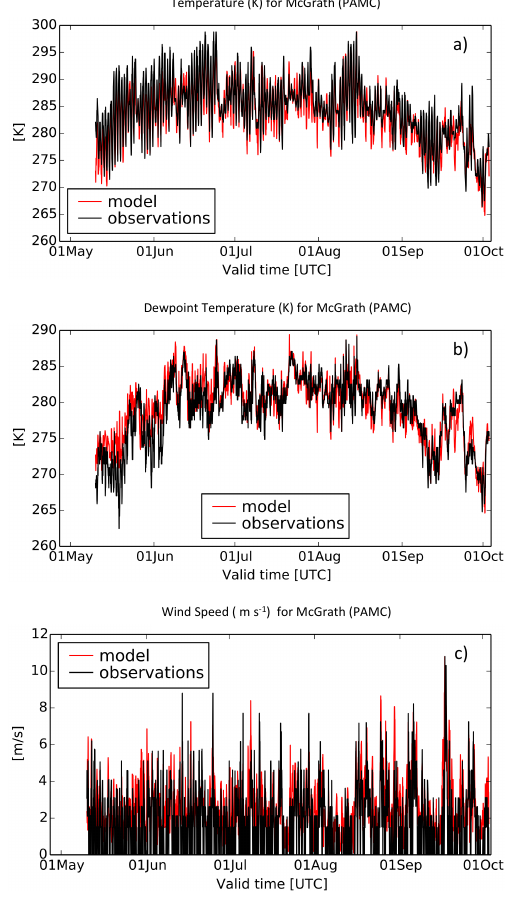
Figure 8. Time series from WRF v3.4.1 of model (red) and obser- vations (black) at McGrath, AK (station ID: PAMC) for the 2012 campaign for (a) temperature (K), (b) dewpoint temperature (K), and (c) wind speed (ms − 1 ). All wind observations are